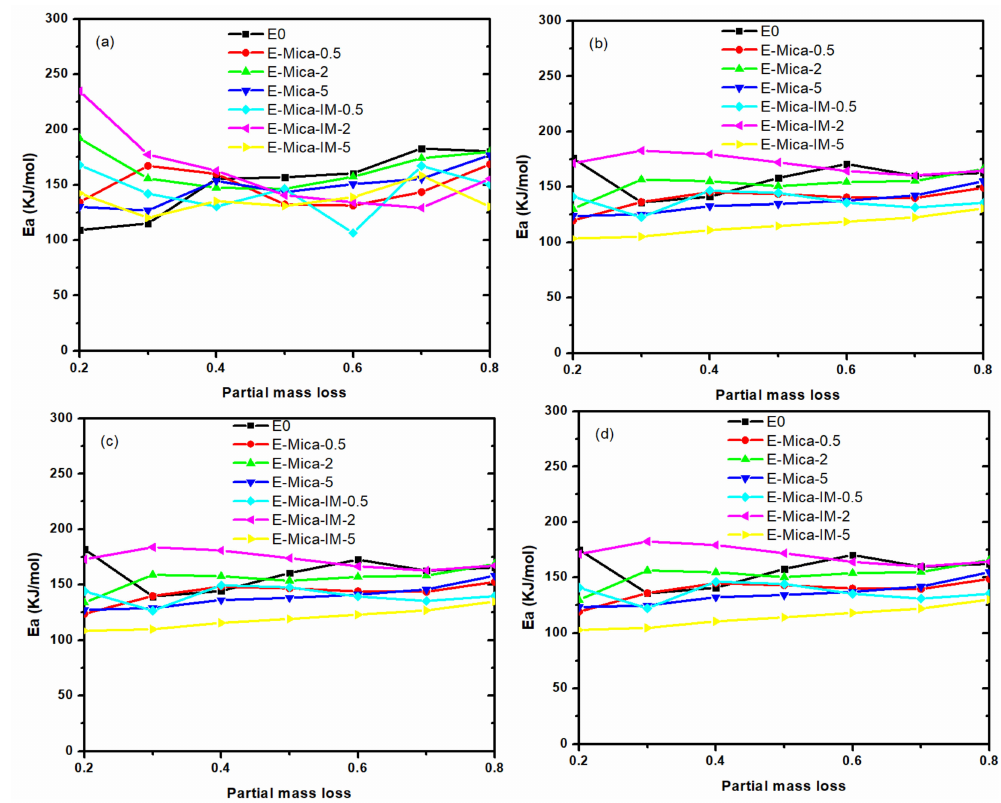
Figure 14. The evolution of the activation energy of thermal degradation against α applying Friedman ( a ) FWO ( b ), KAS ( c ) and m-CR methods ( d ).